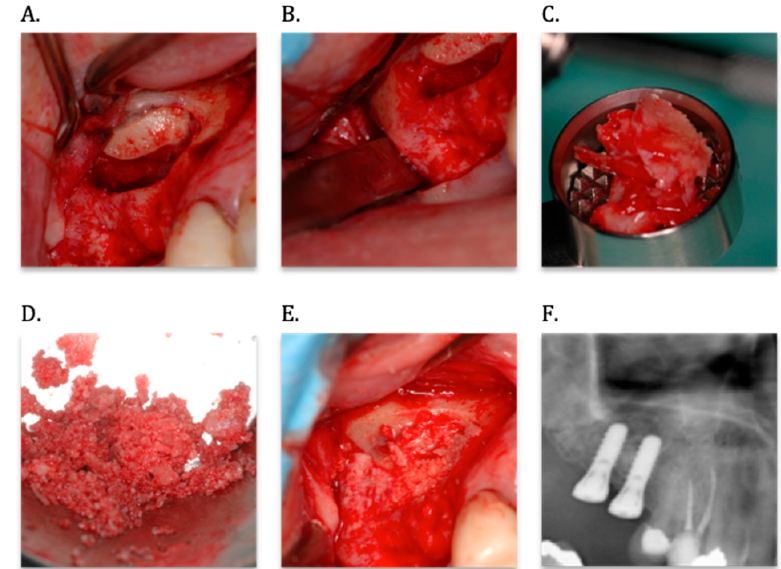
Figure 1. Maxillary sinus floor elevation (MSFE) procedure using a mixture of autogenous bone from the maxillary tuberosity and a biphasic calcium phosphate (BCP). ( A ) The preparation of the top hinge door in the lateral window of the right maxillary sinus. ( B ) Harvesting of an autogenous bone graft from the maxillary tuberosity with a chisel at the same surgical side and during the same procedure. ( C ) The harvested bone graft is grinded in smaller pieces by means of a bone mill. ( D ) The milled bone graft is mixed with a biphasic calcium phosphate (Straumann ® Bone Ceramic 60:40). ( E ) Area between the lifted lid and the maxillary sinus floor is filled with the mixed bone graft. ( F ) Radiograph taken directly after the insertion of two Straumann ® SLA dental implants in the augmented right posterior maxilla (6 months after MSFE).